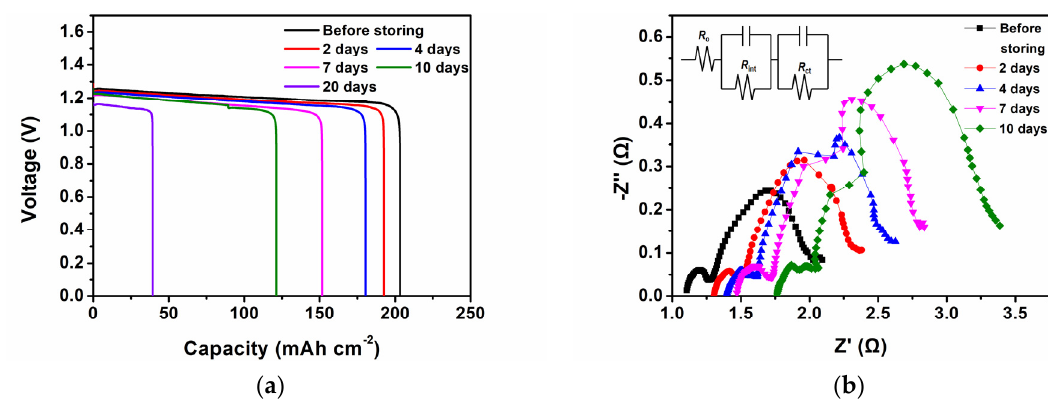
Figure 2. ( a ) Discharge curves of the batteries stored for various days. ( b ) Nyquist plots of the impedance of the batteries before storing and after being stored for various days at a potential of 1.2 V, with an equivalent circuit used in this experiment in the inset. Table 1. Impedance data obtained by fitting the equivalent circuit diagram in the inset of Figure 2b. Storage